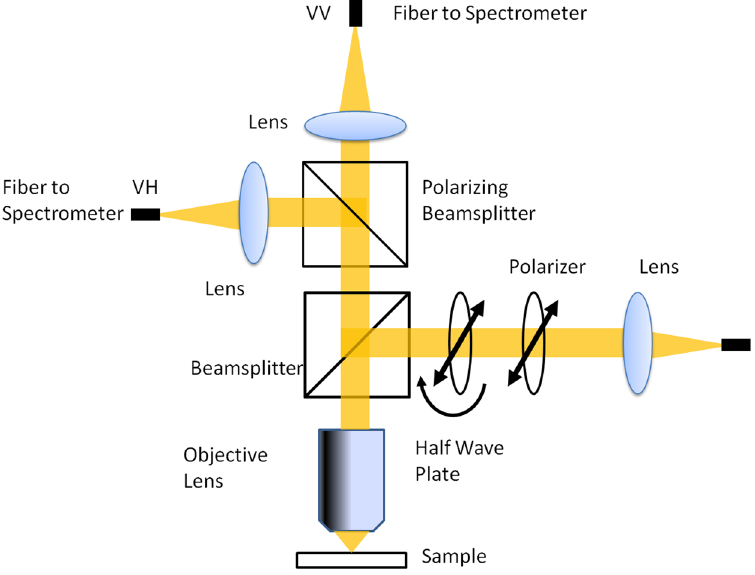
Figure 7. Schematic representation of solid state absorption anisotropy